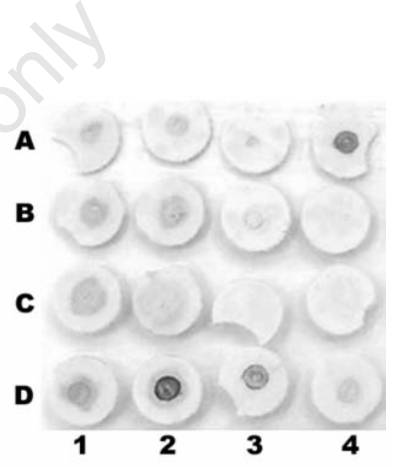
Figure 1. Evaluation of the use of mono- clonal antibodies in immunodot blot tech- nique. A) dengue virus (DENV)-1 + Monoclonal Ab antidengue 1; B) DENV-1 + Monoclonal Ab antidengue 2; C) DENV- 2 + Monoclonal Ab antidengue 1; D)